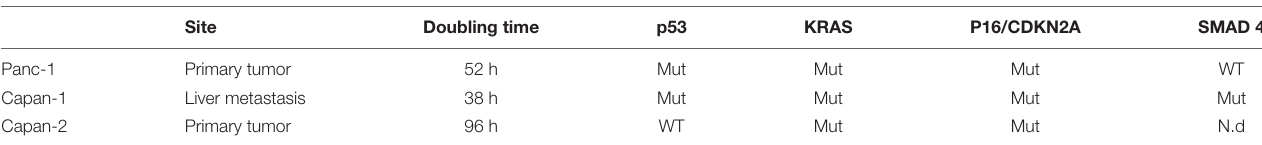
All cell lines were purchased from